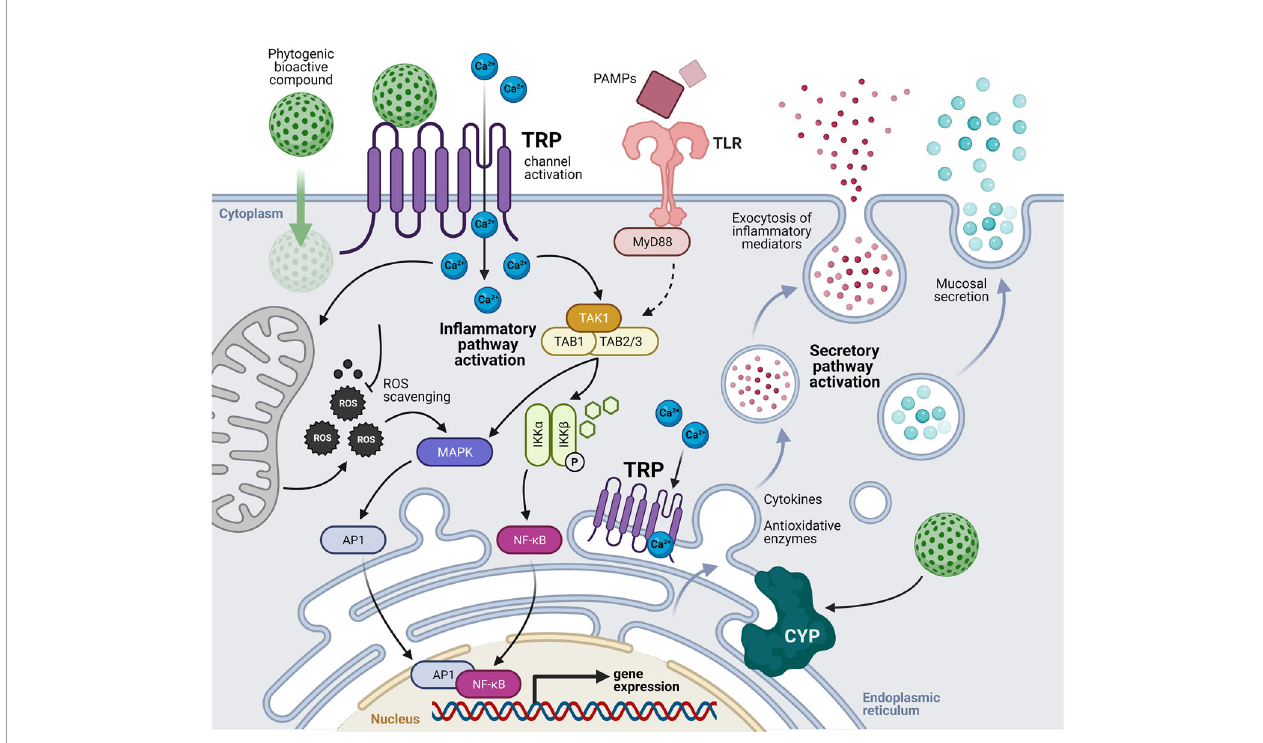
FIGURE 1 | Suggested mechanisms of cell activation by the transient receptor potential (TRP) cation channels mediated by phytogenics ’ bioactive compounds in mucosal-associated lymphoid tissues (MALTs). Bioactive compounds activate TRP channels leading to intracellular Ca 2+ increase and non-canonical activation of the TAK complex. In parallel, stimulation by pathogen-associated molecular patterns (PAMPs) may facilitate the activation of TLR and TRP signaling pathways. Modi fi ed from Galindo-Villegas, et al. (124). TLR, toll-like receptors; MyD88, myeloid differentiation primary response 88; TAK, transforming growth factor beta (TGF b ) activated kinase; TAB, TGF b activated kinase binding protein; ROS, reactive oxygen species; NF- k B, nuclear factor kappa-B; IKK, inhibitor of NF- k B kinase; MAPK, mitogen- activated protein kinase; AP1, activator protein 1; CYP, cytochromes P450; P,